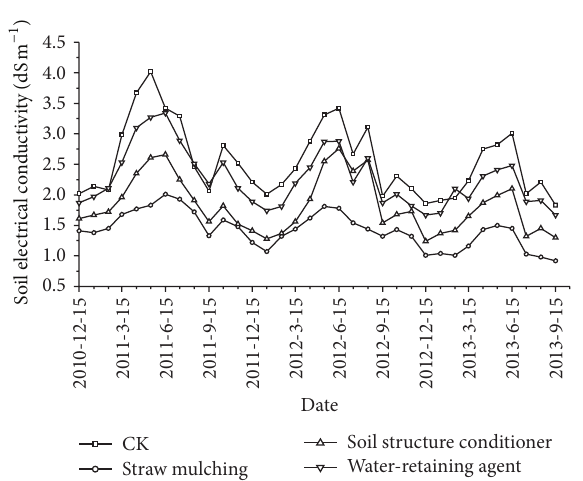
Figure 1: Soil electrical conductivity in 10 cm depth of plough layer with different regulatory methods.